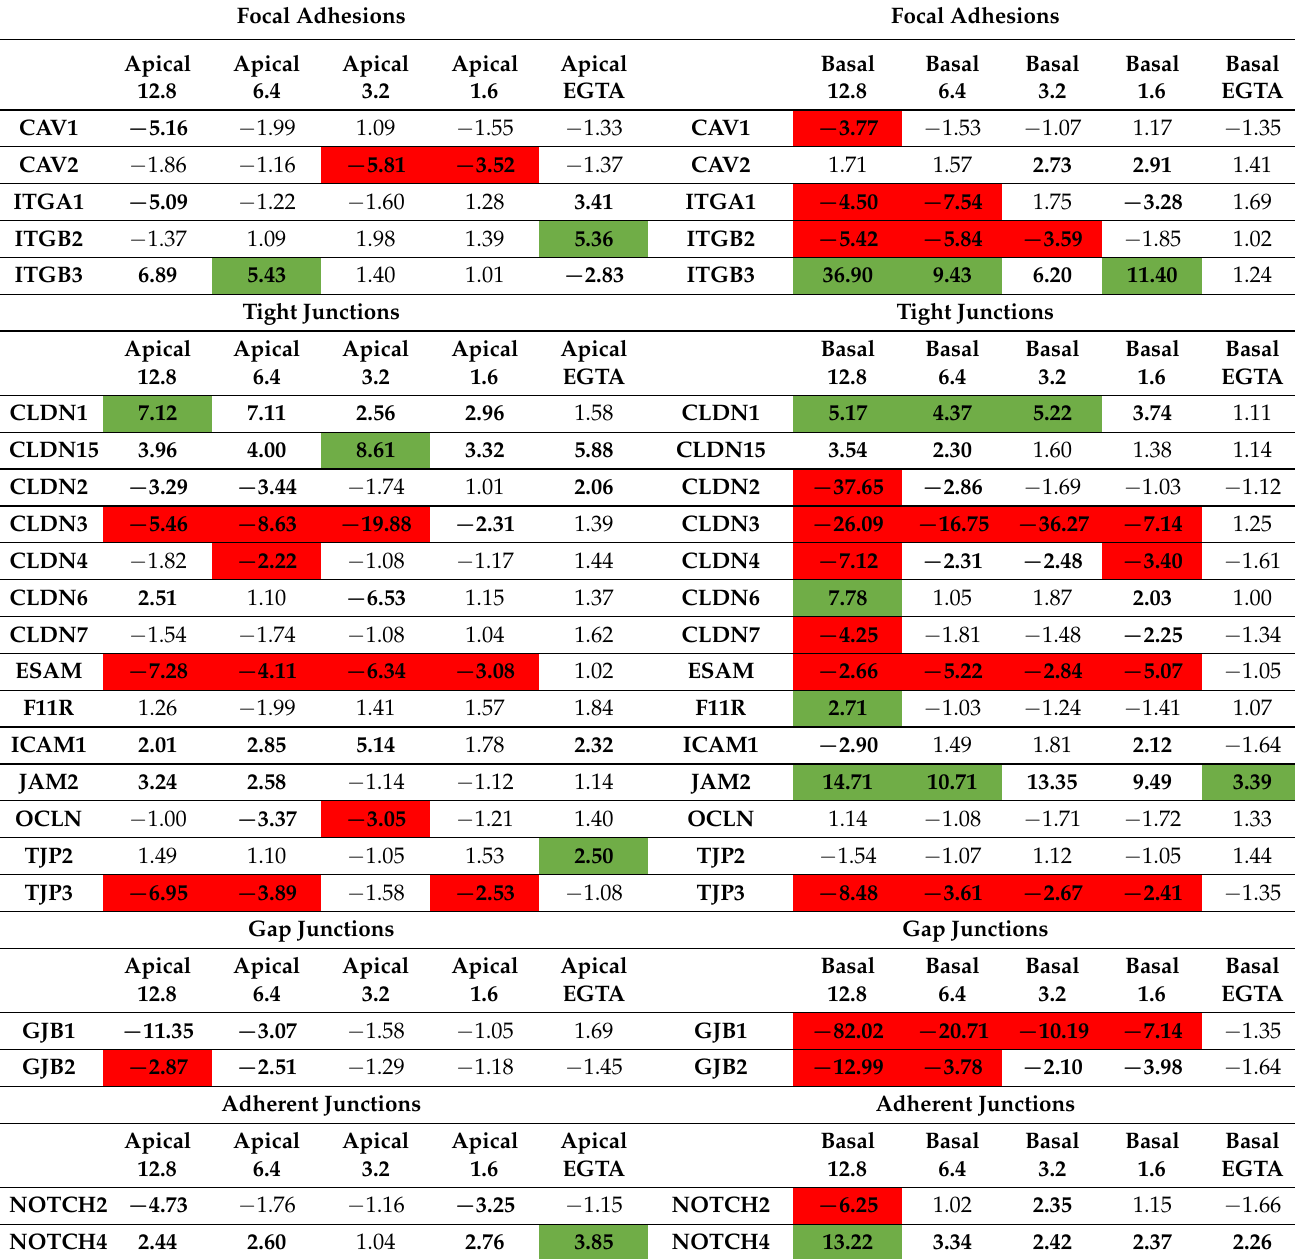
Table 1. Fold regulation of permeability-related genes in T-84 cells after exposure to different concen- trations of sodium arsenite from apical or basolateral compartment. Here, numbers represent the fold regulations compared to control group, more than 2-fold regulations are bolded, and statistically significant change compared to control group are colored. Green color represents upregulation, and red color represents